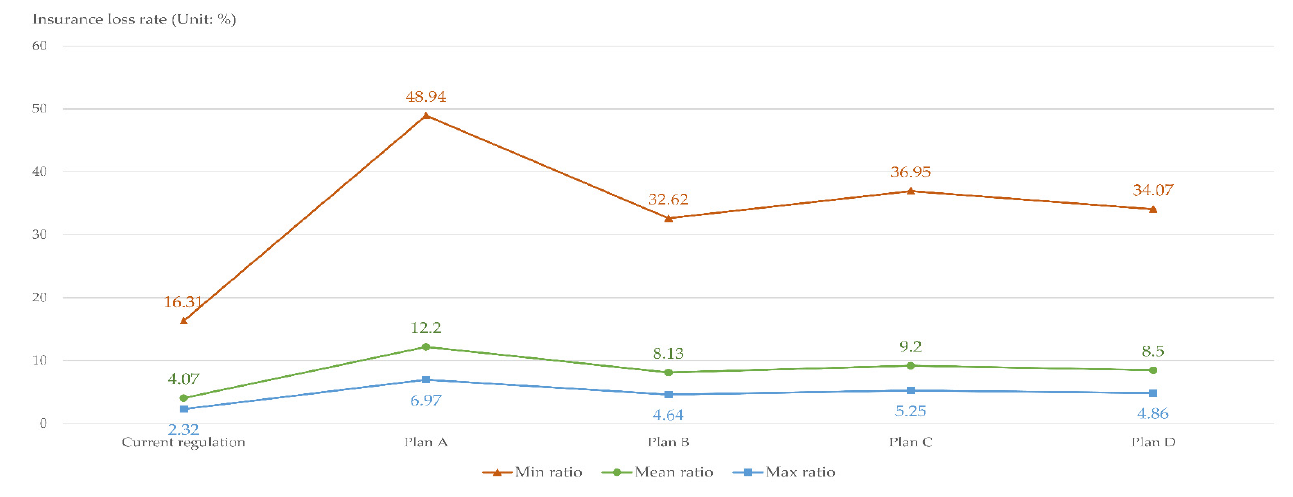
Figure 4. Comparison of the insurance loss rates.